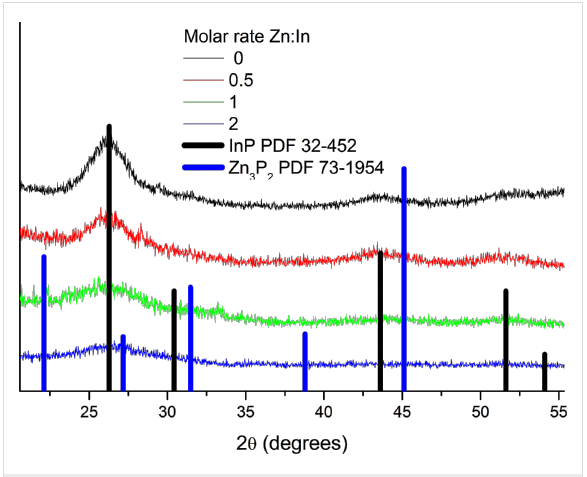
Figure 2: Experimental X-ray powder diffractogram for synthesized InP QDs with different amounts of Zn dopant.